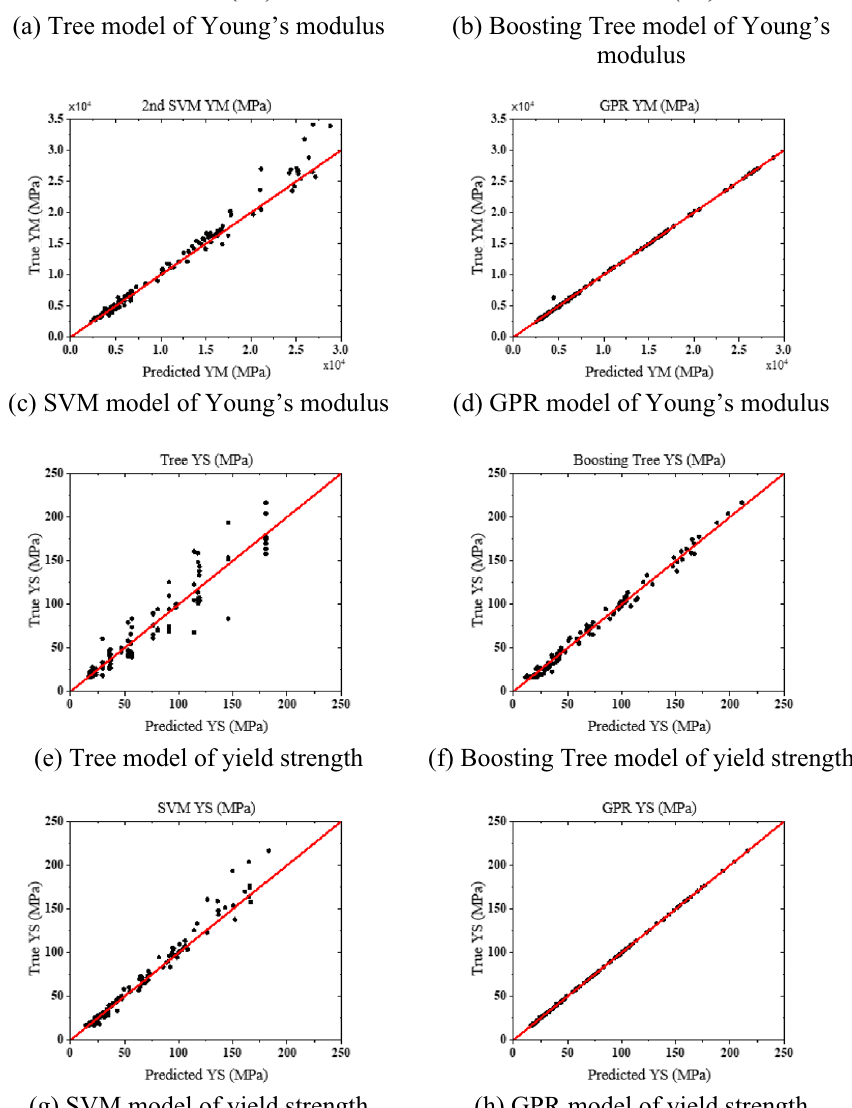
Figure 11. Predicted vs. true Young’s modulus and yield strength of